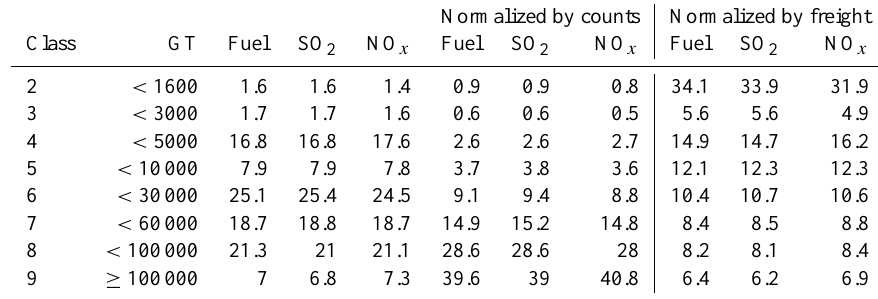
Table 3. Percentage of different ship sizes in fuel consumption and emissions within the model domain in 2011; middle: normalized by the number of ships in every class; right: normalized by the transported freight volume in every class (estimated from the gross tonnage). Normalized by counts Normalized by freight Class GT Fuel SO 2 NO x Fuel SO 2 NO x